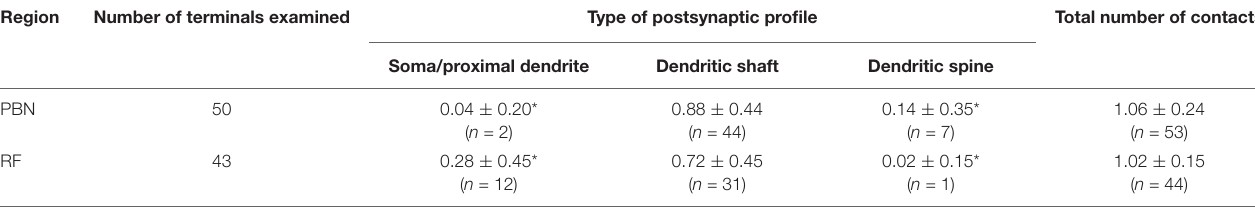
TABLE 2 | Frequency of occurrence (mean ± SD) of different types of synaptic contacts per labeled terminal of rNST neurons in the PBN and medullary RF.